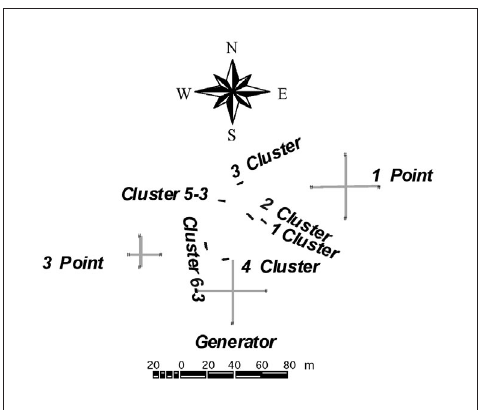
Fig. 5. The disposition of electric dipoles approxi- mating a field of sources of the recorded signals for the third interval of observation. The disposition of meas- uring and generating lines are also shown in the